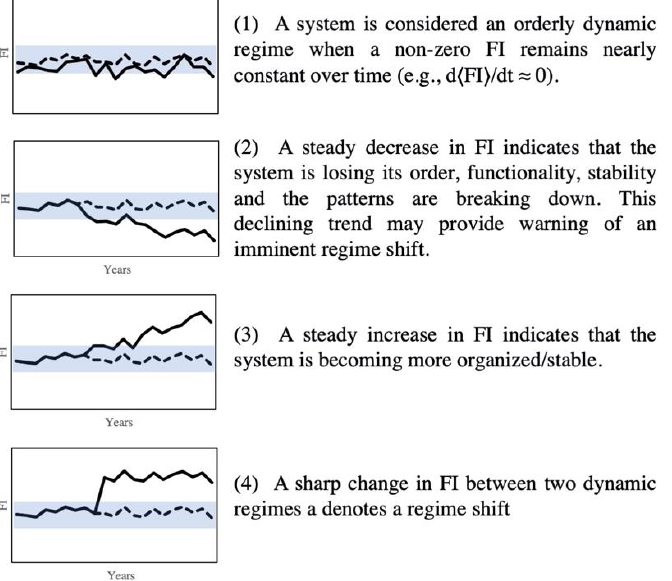
Figure 6. F1 patterns of the Sustainable Regime Hypothesis. The dotted line indicates a natural system’s regime, and the solid line indicates a regulated system’s regime. The blue shaded region denotes the boundaries for a regime shift, estimated as the two-standard deviation from the natural system’s mean FI [56]. The subfigure (1) indicates an oderly dynamic system, (2) a steady decrease in FI of the regulated system, (3) a steady increase in the regulated system, and (4) a sharp increase in the regulated system.